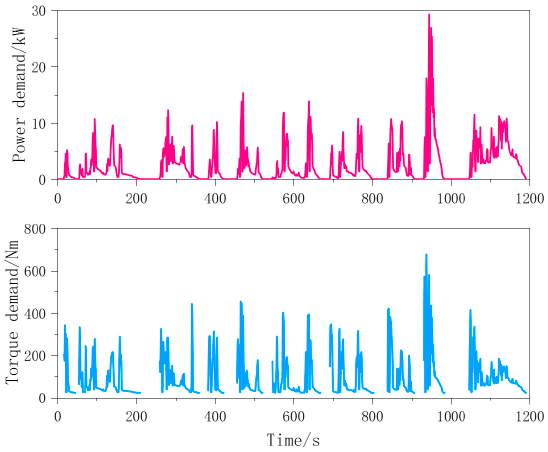
Figure 8. The demand torque/power in the China urban passenger driving cycle (CUPDC).